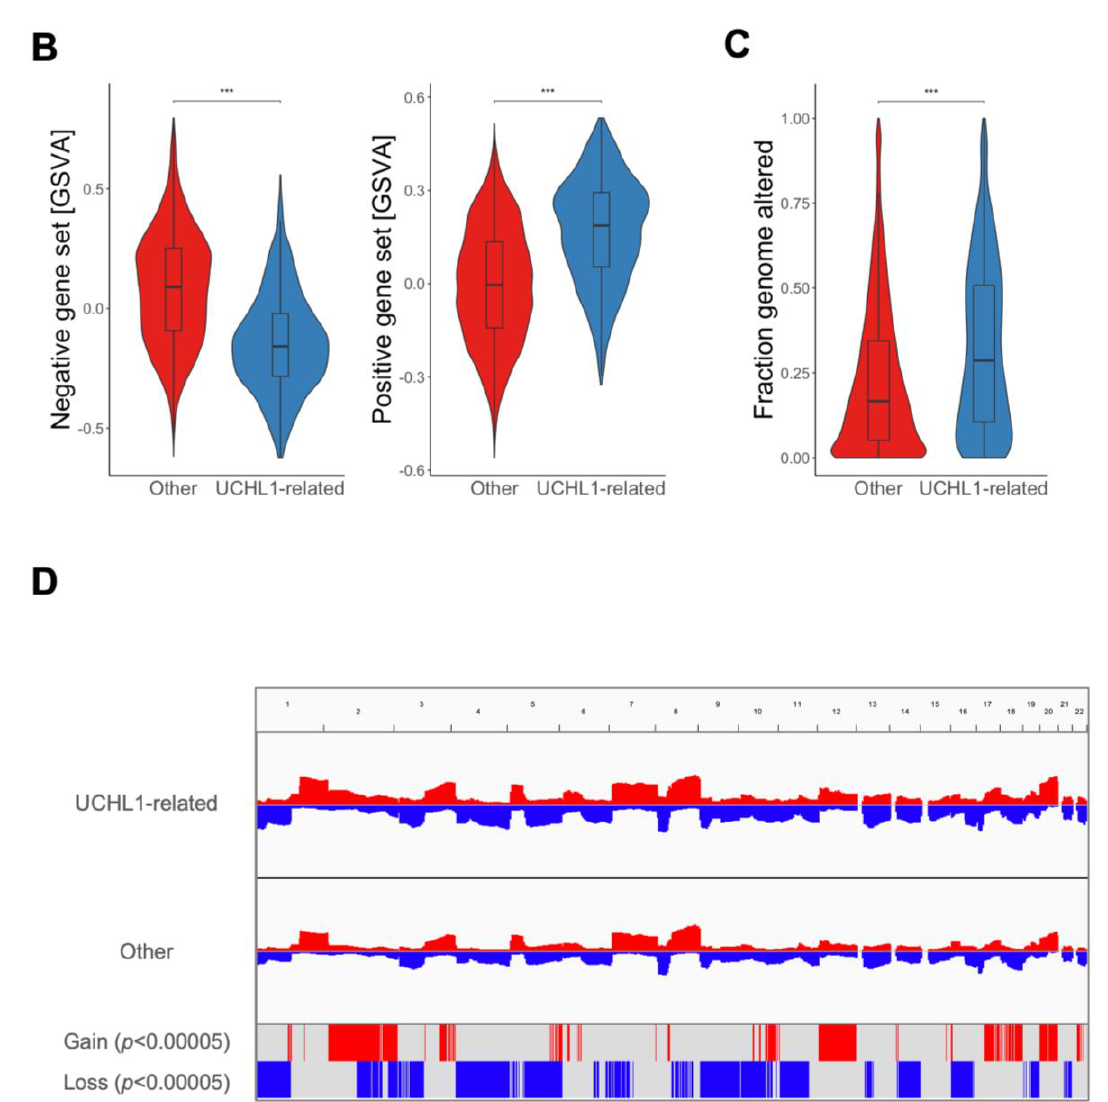
Figure 3. UCHL1-related cancers across solid tumors from TCGA-PanCancer. ( A ) Bar plot indicates relative frequency of UCHL1-related cancers across solid tumor entities of TCGA-PanCancer predicted by the classification model. ( B ) Violin plots show significant differences of GSVA scores for UCHL1-related gene sets with either a negative (left) or positive association (right) to UCHL1 expression between UCHL1-related (blue) and other tumors (red). ( C ) Violin plot shows a significant difference in the fraction of altered genome between UCHL1-related (blue) and other tumors (red). ( D ) CNV plot illustrates relative frequencies of copy number gains (red) and losses (blue) for UCHL1-related and other tumors with indicated hot spot regions according to a significance level ( p < 0.00005) by a Fisher exact test. *** p < 0.0005 based on Wilcoxon rank sum